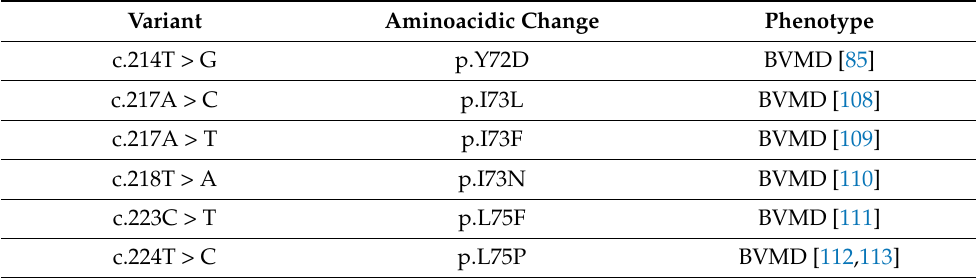
Table 2. List of BEST1 variants identified in the transmembrane domain 2 (TM2) along with the aminoacidic change caused by the mutation and the associated